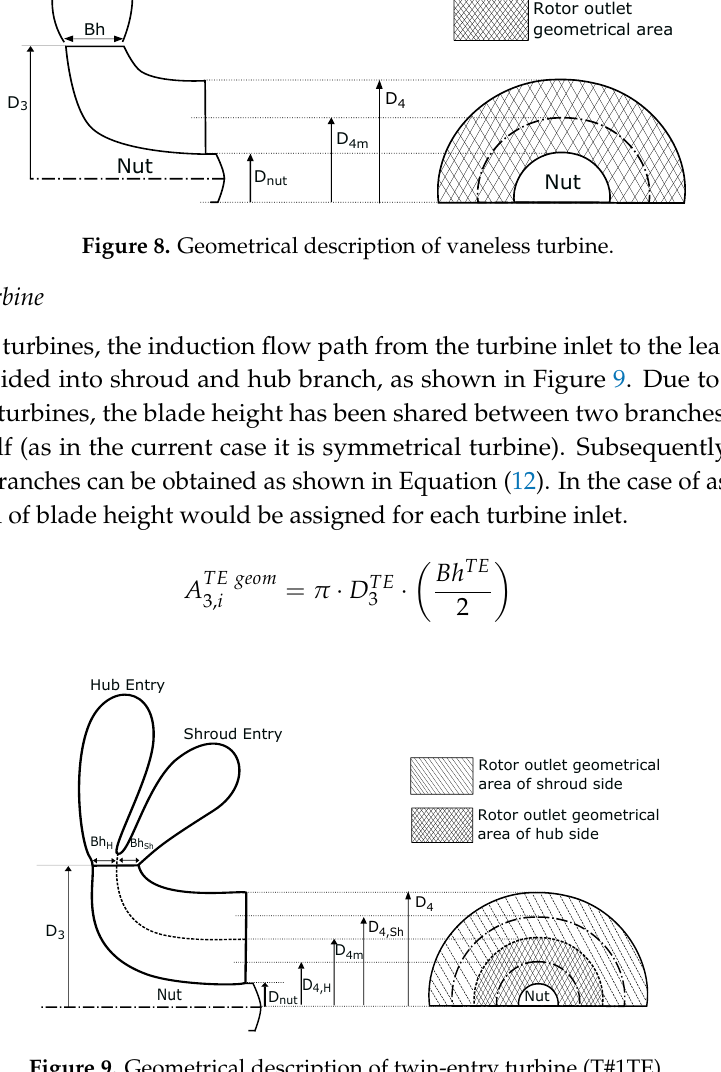
Figure 9. Geometrical description of twin-entry turbine